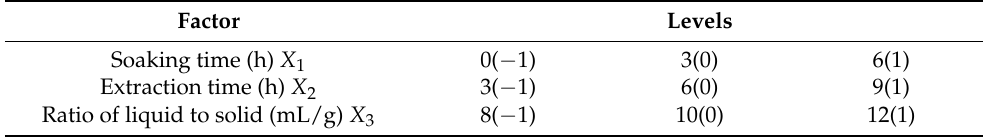
Table 1. Three factors and three levels of response surface methodology. Factor